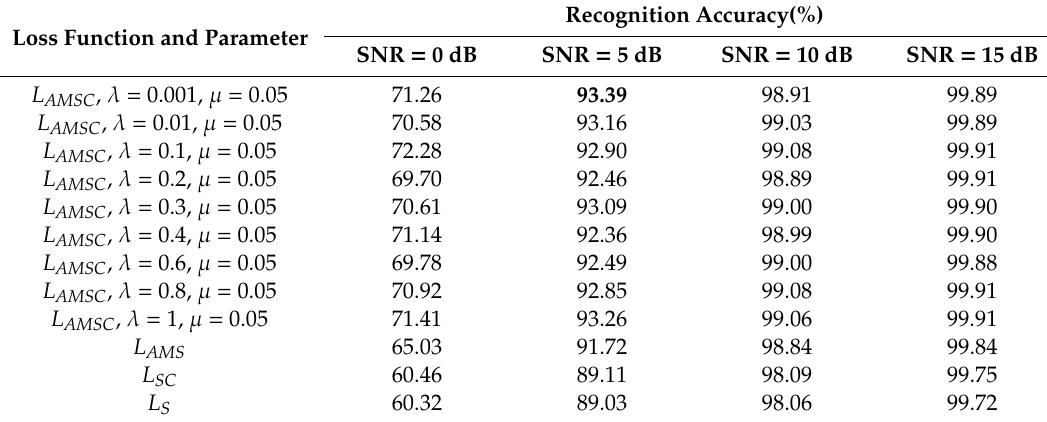
Table 3. Recognition accuracy of model A when the λ in loss function L AMSC is di ff erent while the dataset is under di ff erent SNR